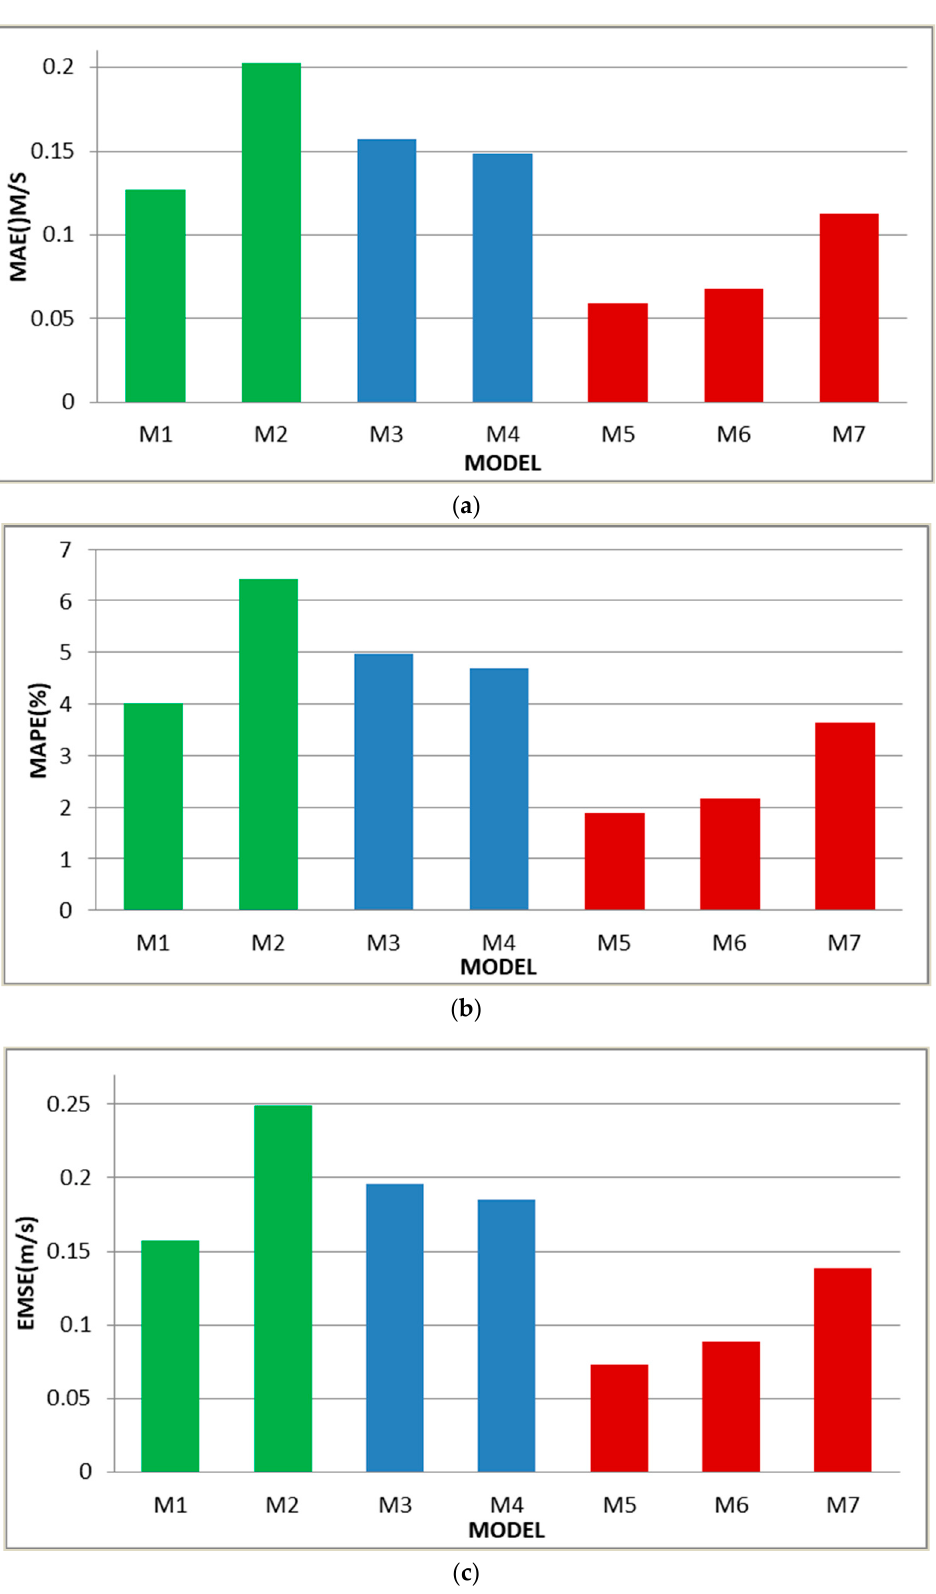
Figure 12. Supplemental case error analysis histogram: ( a ) MAE; ( b ) MAPE; ( c ) RMSE.